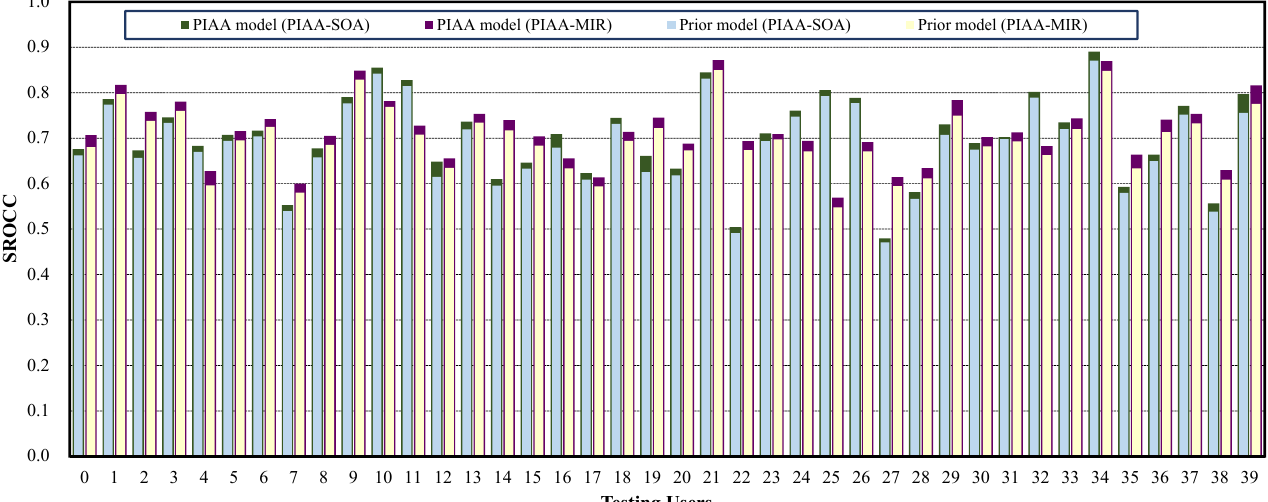
Figure 3. SROCC results of PIAA-SOA [27] and our PIAA-MIR on the 40 testing users of the PAPA database [10]. The testing results of the prior model and PIAA model on each user are shown. Specifically, the testing results of PIAA-SOA are displayed with blue and green bars, and the testing results of PIAA-MIR are displayed with yellow and purple